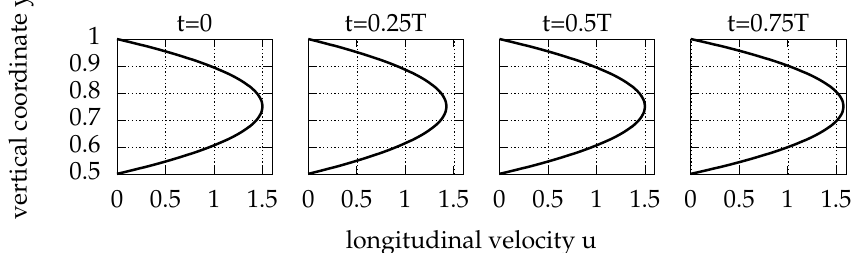
Figure 10. Inflow velocity profiles for four time instances during the period (Equation (1)). The oscillation amplitude is α =